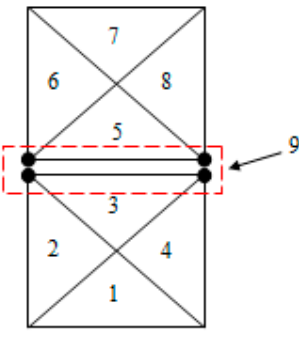
Figure 4. Schematics showing the bi-grain case study.